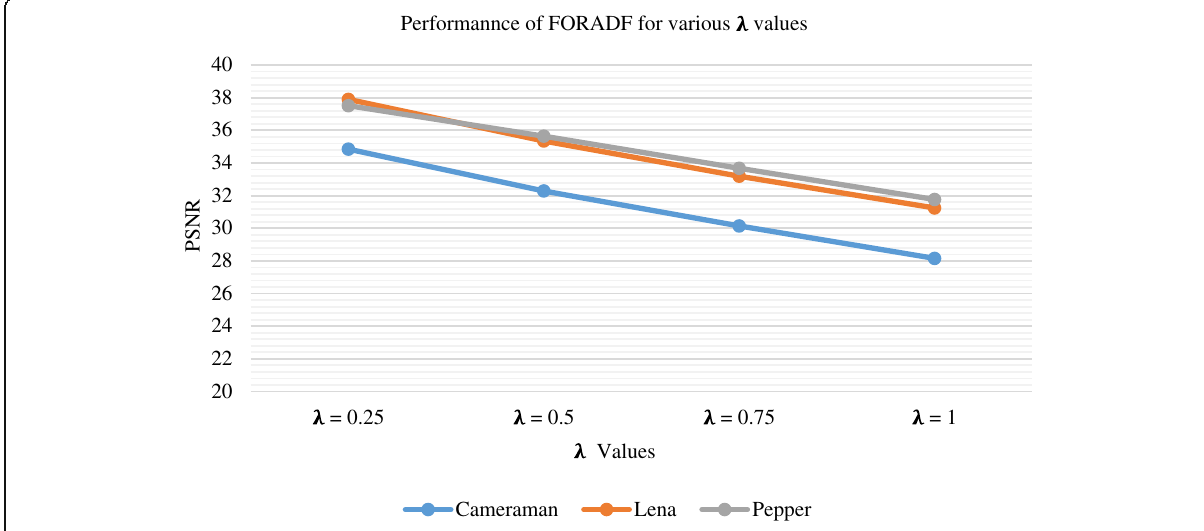
Fig. 10 Performance of FORADF in terms of PSNR for various λ values at 20% salt and pepper noise density for n = 5. λ represents the control parameter, and n represents the number of iterations. The figure shows the stability of FORADF for various λ values, and the performance is measured in terms of the performance metric PSNR. FORADF for Lena image.